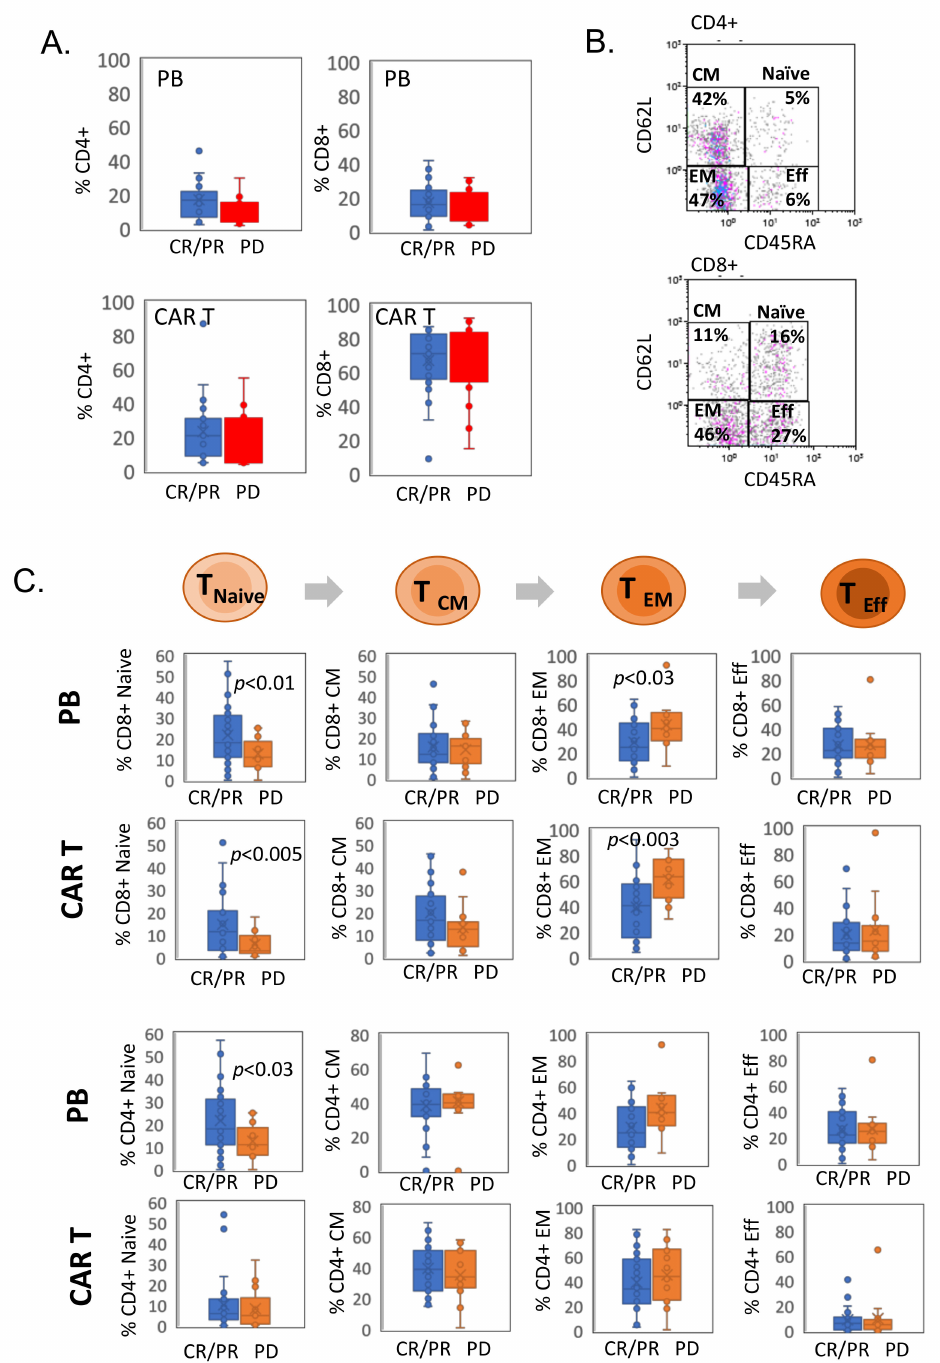
Figure 1. CAR T cell phenotype characterization. ( A ) Frequency of CD4 + and CD8 + cells in the peripheral blood (PB) mononuclear cells at the time of leukapheresis and in manufactured pre- infused CAR T cell products from patients in each response group (CR/PR, n = 28; PD, n = 14). ( B ) Representative flow cytometry dot plots examining the proportions of naive (CD45RA + CD62L + ), central memory (CM; CD45RA - CD62L + ), effector memory (EM; CD45RA - CD62L - ) and effector (Eff; CD45RA + CD62L - ) subsets in CD8 + and CD4 + lymphocytes taken from CAR T cell product of non- responding patient. The cells were pre-gated on CD4 + and CD8 + populations. ( C ) The percentages of naive, CM, EM and Eff CD8 + and CD4 + T cells in the PB at the time of leukapheresis and in manufactured pre-infused CAR T cell products from patients in each response group (CR/PR, n = 28; PD, n =